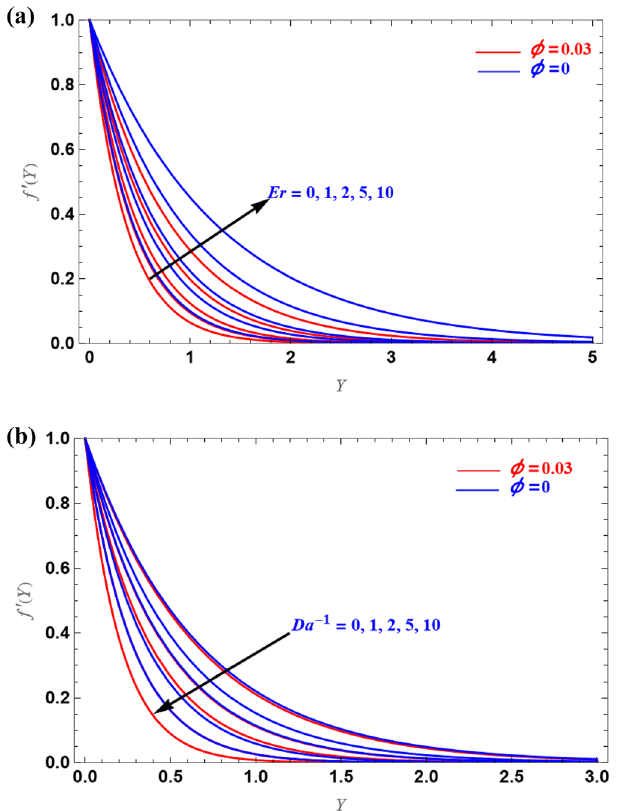
Figure 4. ( a , b ) Representation of f ′ ( Y ) versus Y